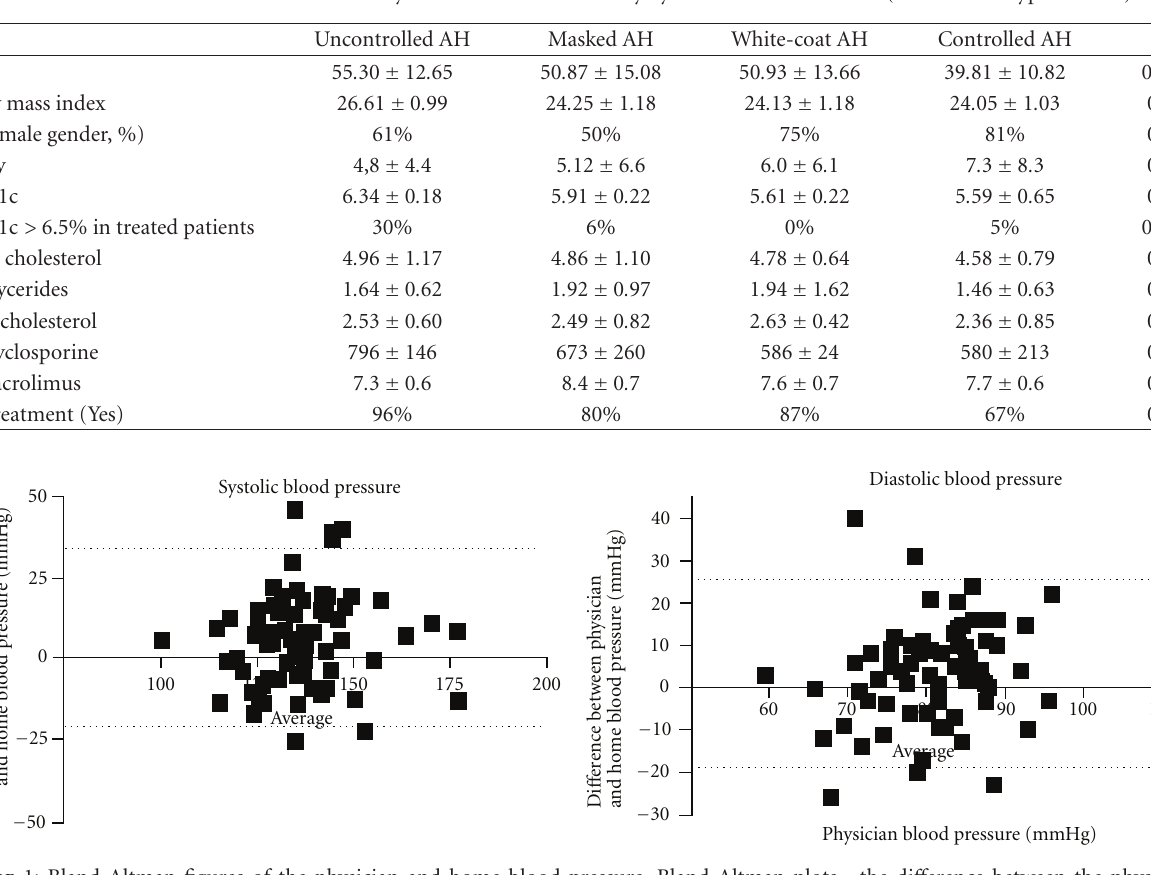
Figure 1: Bland-Altman figures of the physician and home blood pressure. Bland-Altman plots—the di ff erence between the physician and home blood pressure—are plotted against the physician blood pressure; therefore, a positive di ff erence suggests an overestimation by physician, whereas a negative di ff erence suggests an underestimation. The solid lines represent the mean di ff erence between physician and home blood pressure; the dashed lines represent the 95% lines of agreement. For systolic blood pressure, the values are bias: 5.86; SD of bias: 14.25; 95% limits of agreement ( − 22.08, 33.79). For diastolic blood pressure, the value is bias: 3.59; SD of bias: 11.80; 95% limits of agreement ( − 19.54,